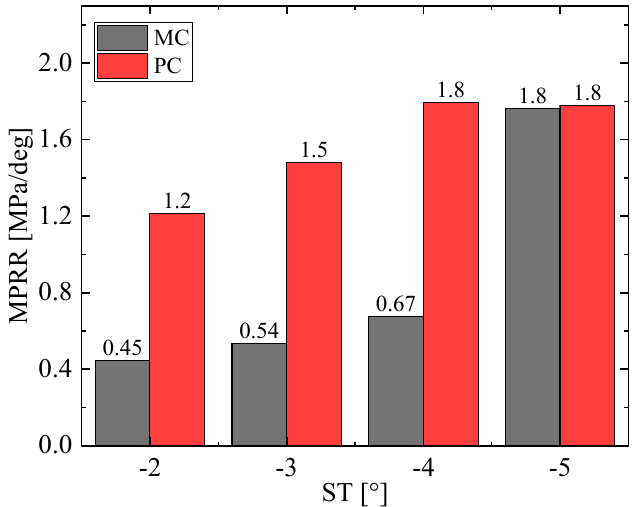
Figure 14. Predicted MPRR for PCFR = 0%, CR = 14, and λ = 4 using different STs.